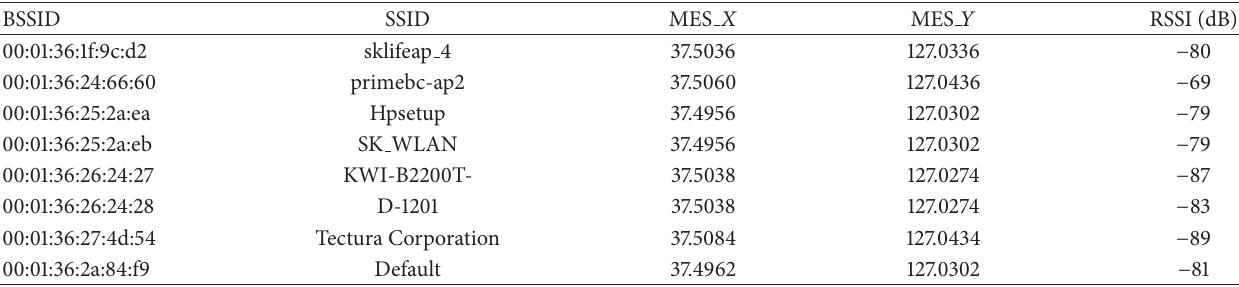
Figure 8: Example of single-size regular grid segmentation. Table 1: Example of a Wi-Fi AP